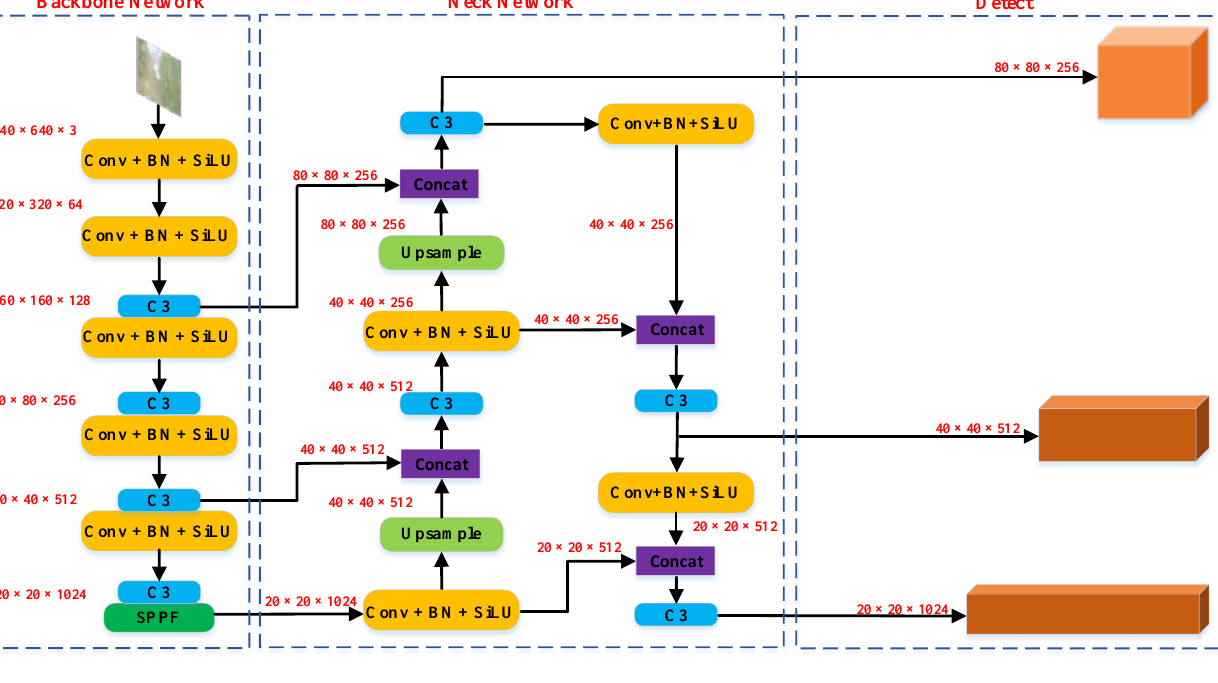
Figure 2. YOLO v5s algorithm model (1).